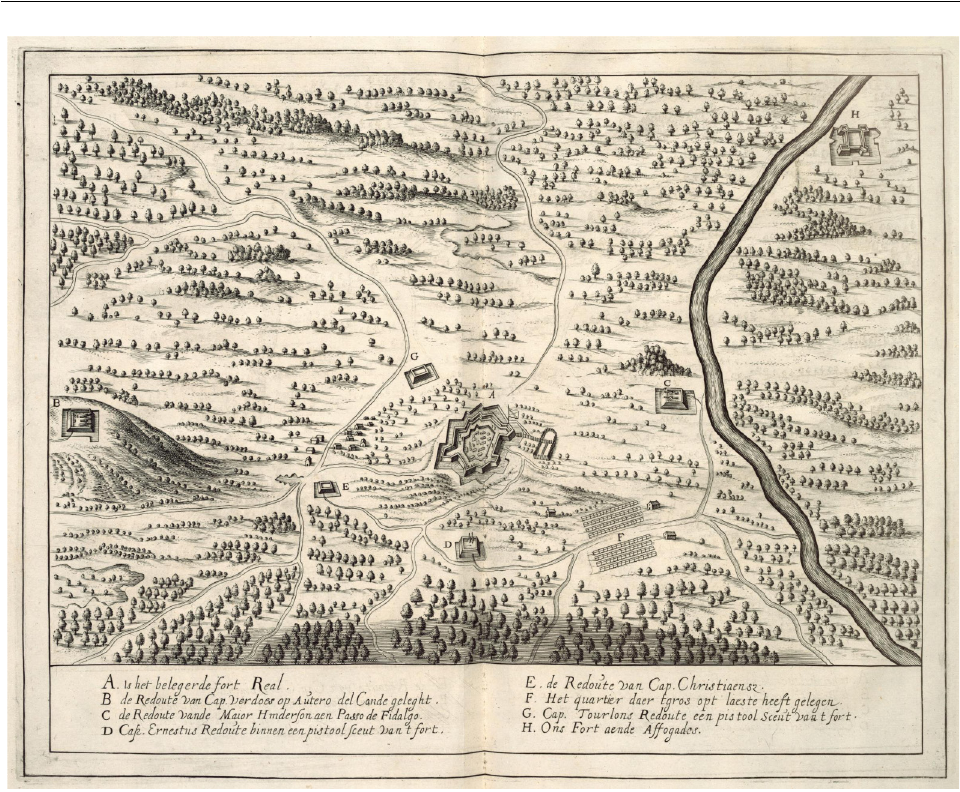
Fig. 8. The siege of Arraial Velho do Bom Jesus. J. de Laet 1644, after p.